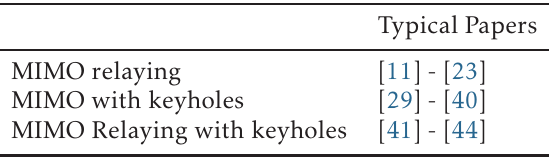
Table 1. Summary of related papers Typical